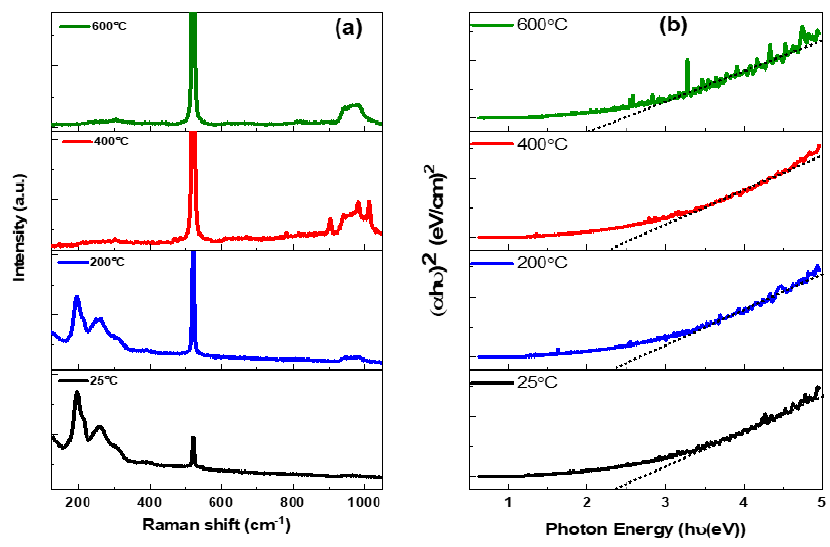
Figure 6. As-deposited GeSe4 thin films at various substrate temperatures:( a ) Raman spectra, and ( b ) Tauc plots.